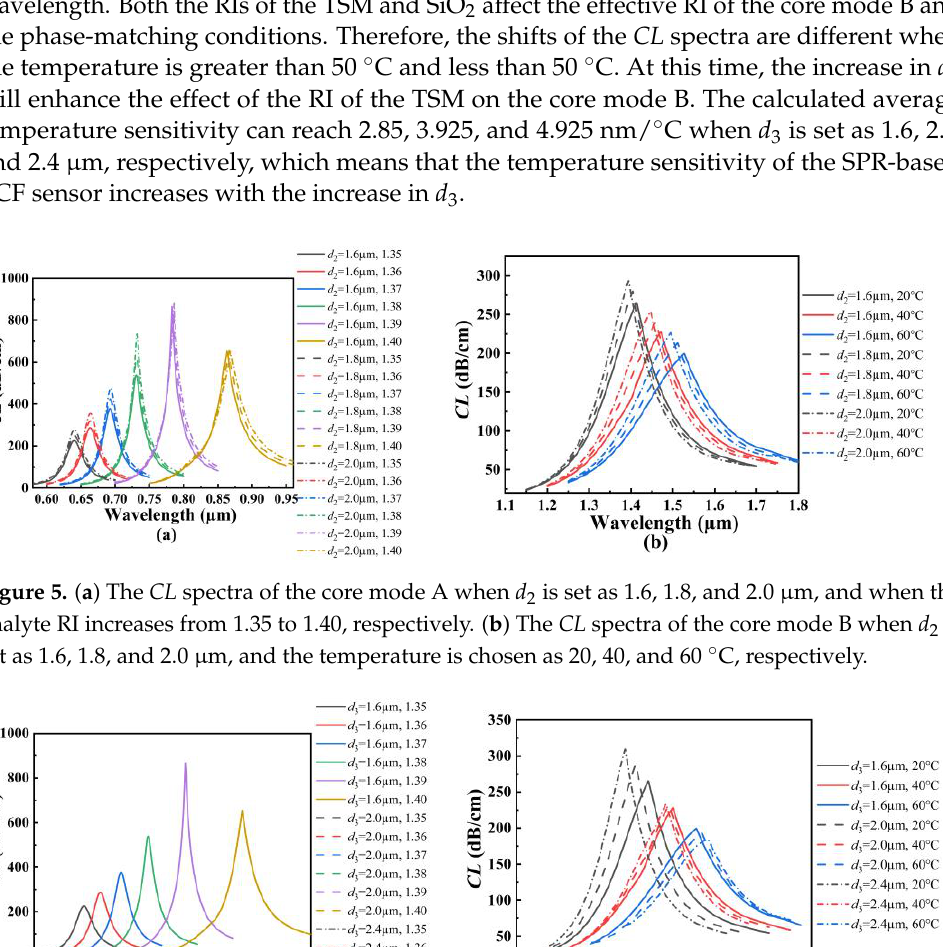
Figure 5. ( a ) The CL spectra of the core mode A when d 2 is set as 1.6, 1.8, and 2.0 μm, and when the analyte RI increases from 1.35 to 1.40, respectively. ( b ) The CL spectra of the core mode B when d 2 is